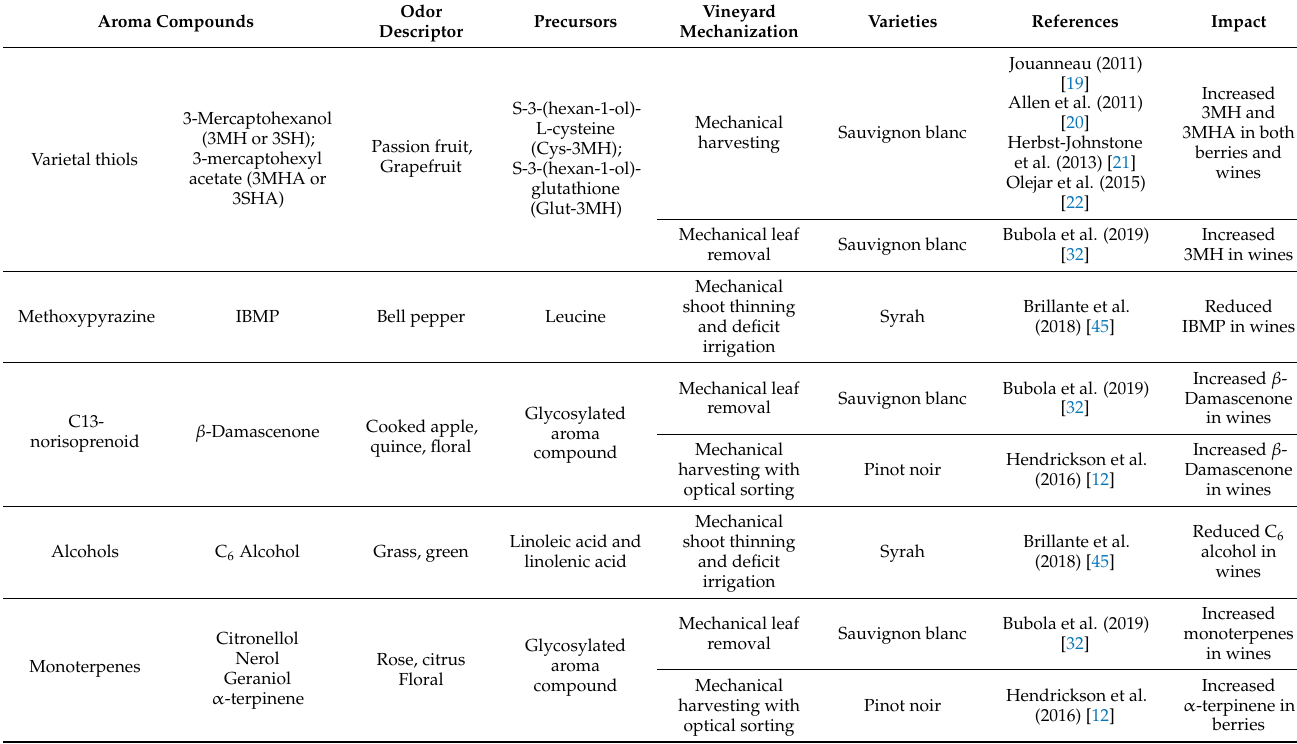
Table 2. The impact of vineyard mechanization on grape and wine aroma